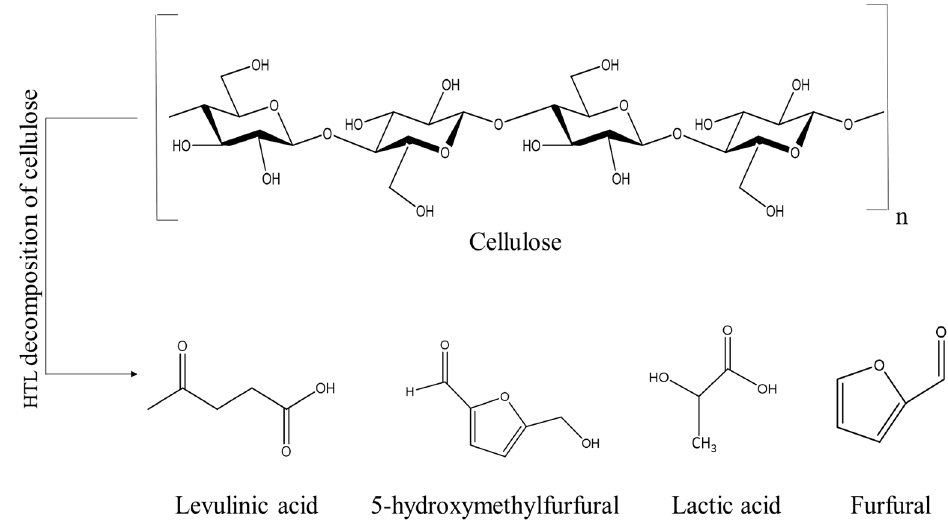
Figure 3. Decomposition products during cellulose liquefaction.